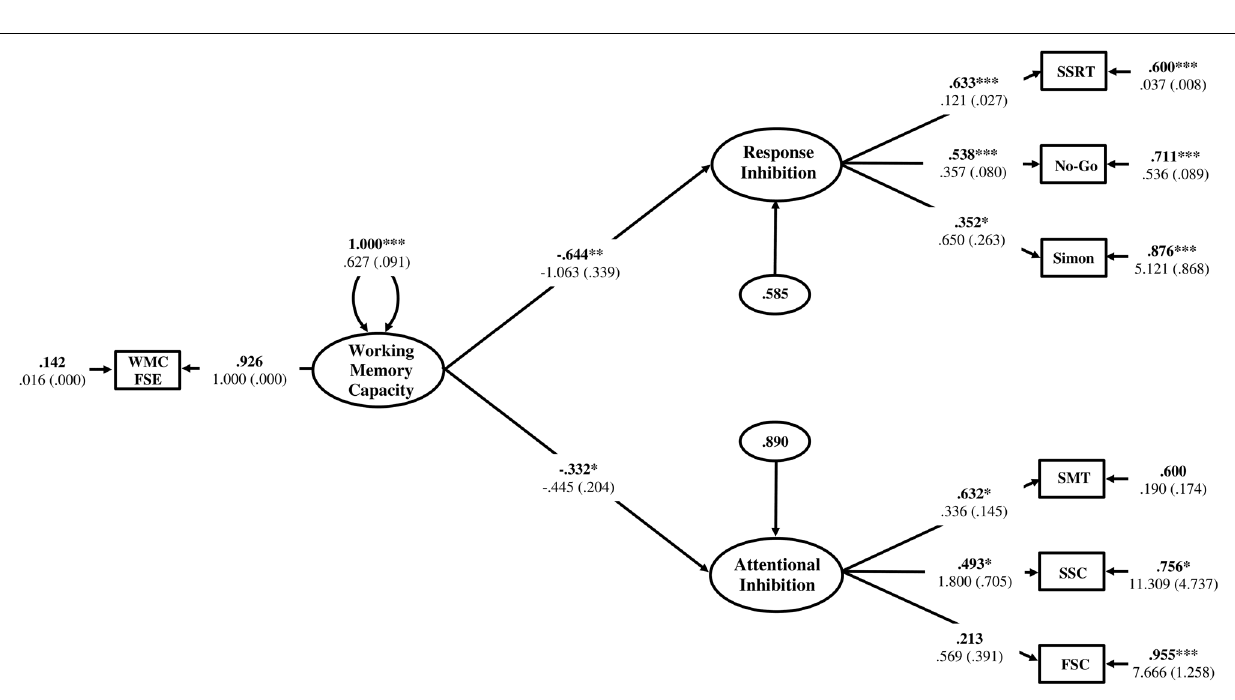
FIGURE 9 | Hierarchical model of inhibitory control with the residual correlation between Response Inhibition and Attentional Inhibition factors constrained to zero. WMC FSE, Working Memory Capacity Factor Scores Estimates; SSRT, Stop-Signal Reaction Time; No-Go, Commission errors on Go/No-Go task; Simon, Simon SR-conflict; SMT, Shape matching SS-conflict; SSC, Stroop SS-conflict; FSC, Flanker SS-conflict. Fully standardized estimates are in bold type face. Numbers below are unstandardized parameter estimates with bootstrapped standard errors in brackets. ∗∗∗ p < 0.001, ∗∗ p < 0.01, ∗ p <